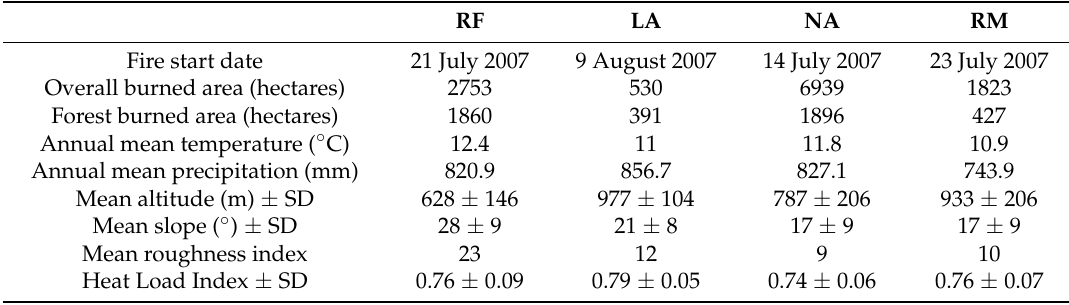
Table 1. Wildfire information, and climate and landform properties of the four study areas: Roccafluvione (RF), L’Aquila (LA), Navelli (NA), and Roccamorice